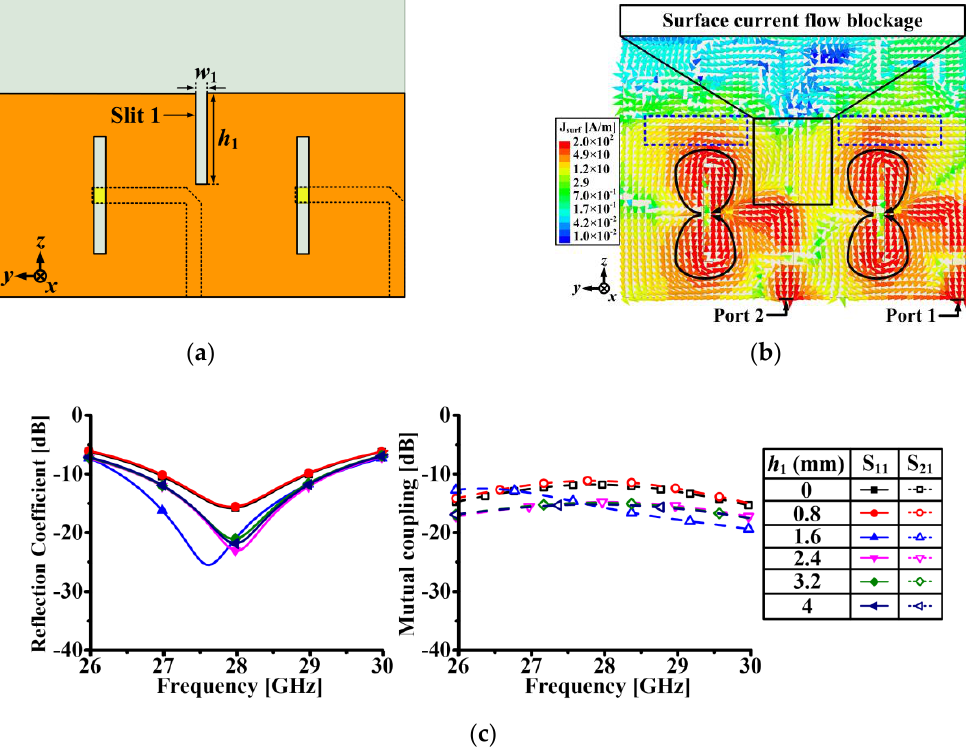
Figure 3. A 1 × 2 array antenna without directors: ( a ) top view, and ( b ) simulated surface current distribution at 28 GHz.